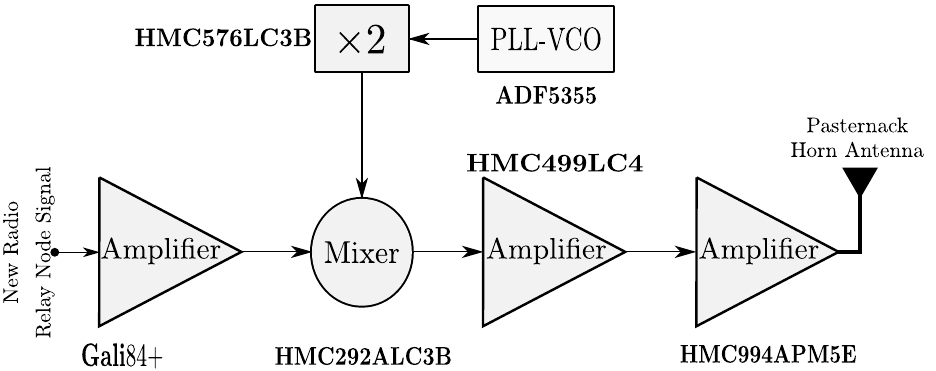
Figure 6. Subsystems of the mmWave transmitter chain (FR2-Tx). Table 1. Parameters of the elements of mmWave transmitter and receiver chains.